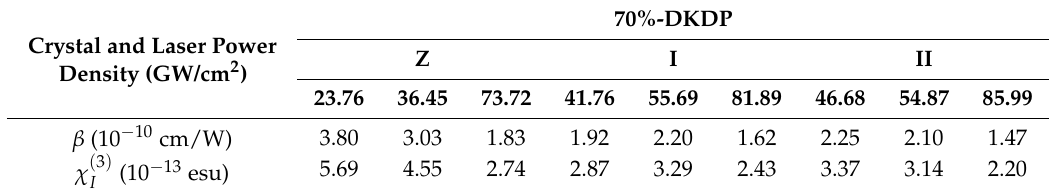
Table 2. Calculated results of nonlinear absorption parameters for 70%-DKDP crystal at λ = 532 nm.